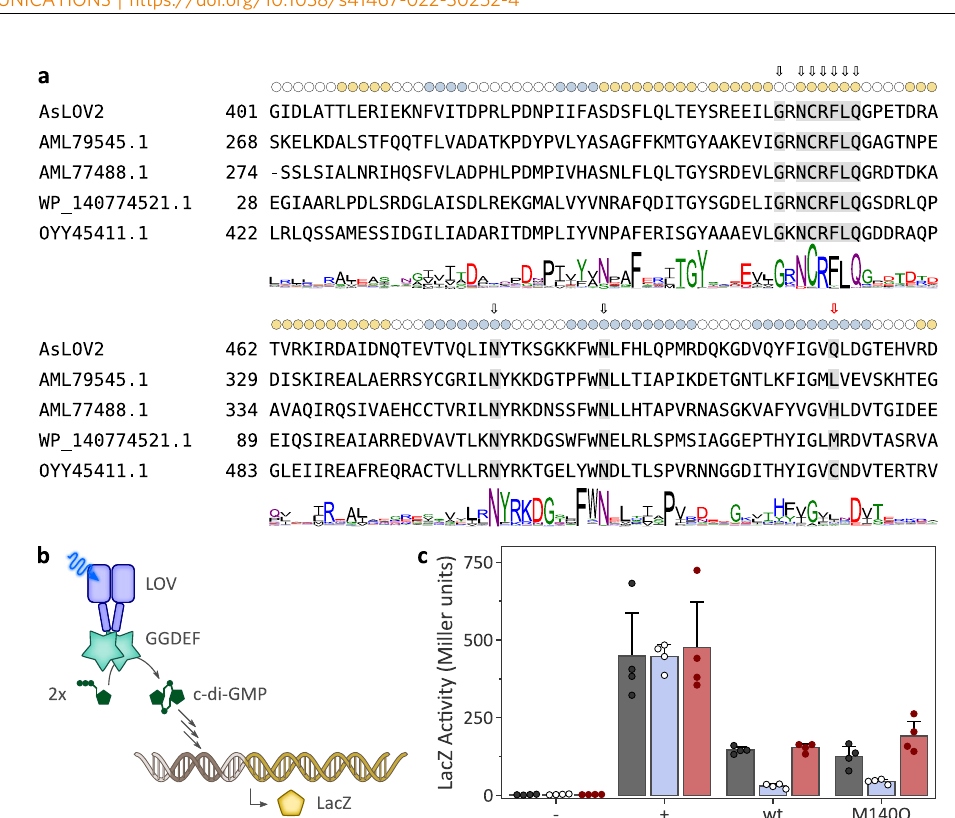
Fig. 6 Naturally occurring, glutamine-de fi cient LOV Δ Q receptors. a Sequence searches identify around 350 receptors that have homology to bona fi de LOV receptors but lack the conserved active-site glutamine. The multiple sequence alignment shows As LOV2 as a reference and four selected glutamine- de fi cient receptors. The sequence logo below the alignment was calculated for the entire set of glutamine-de fi cient LOV receptors (see Suppl. Data 3). Coloring, shading, and arrows as in Fig. 1, with the position of the conserved glutamine residue indicated by a red arrow. b Activity and light response of the LOV Δ Q -GGDEF fragment of WP_140774521.1 were assessed in an E. coli reporter strain harboring a dgcE knockout and a translational fusion between the cyclic-di-GMP-controlled csgB and lacZ . Light-dependent diguanylate cyclase activity can hence be gauged by measuring β -galactosidase levels. c Bacteria expressing the wild-type LOV Δ Q -GGDEF receptor or the M140Q variant were cultivated in darkness (black dots and gray bars), under blue light (white dots and blue bars), or under red light (red dots and bars). ‘ − ‘ refers to an empty-vector negative control, and ‘ + ’ denotes a strain expressing the major diguanylate cyclase DgcE that served as the positive control. β -galactosidase activity is reported in Miller units and represents mean ± s.d. of four biologically independent replicates. The experiment was repeated twice with a similar